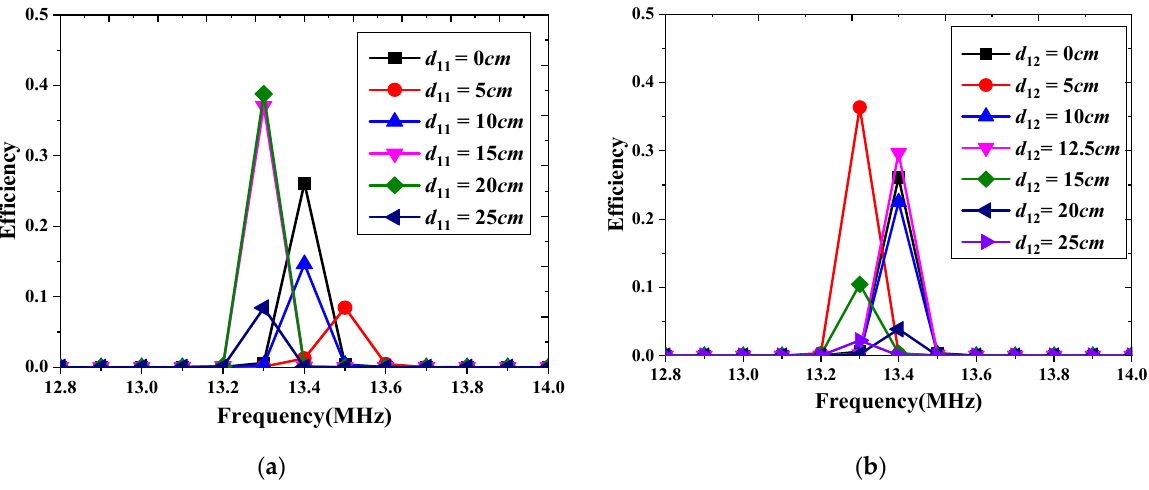
Figure 11. The efficiency of the STSR WPT system in different cases, ( a ) case5 and ( b ) case 6.